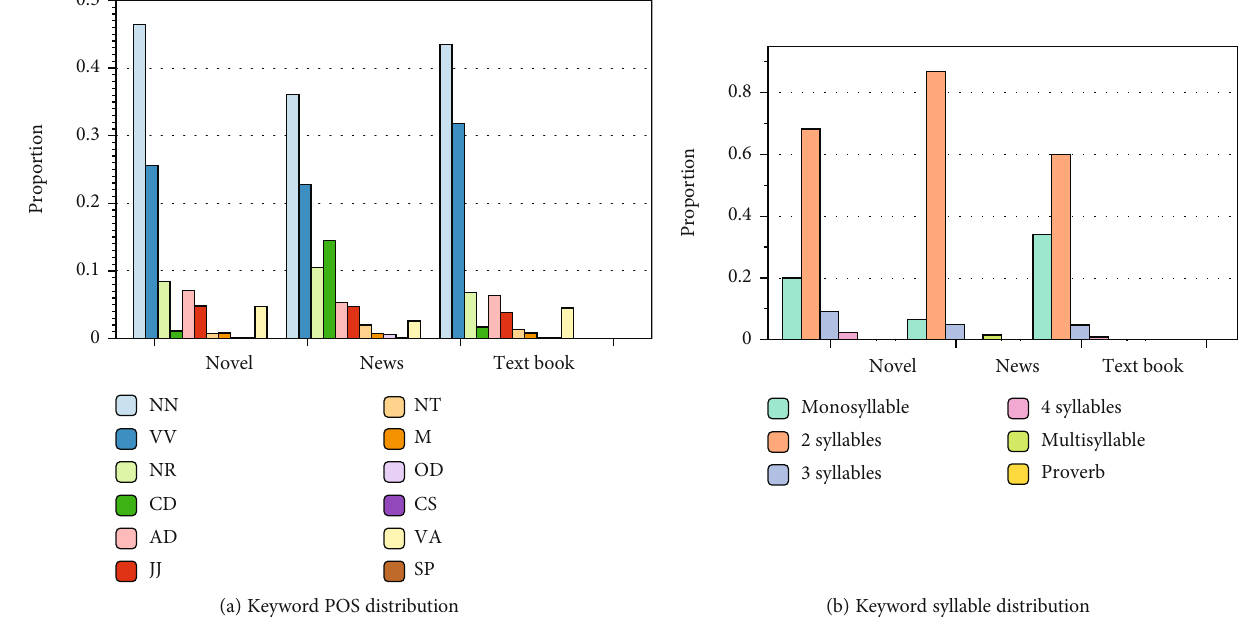
Figure 5: Keyword POS and syllable distribution. Table 4: Abbreviation